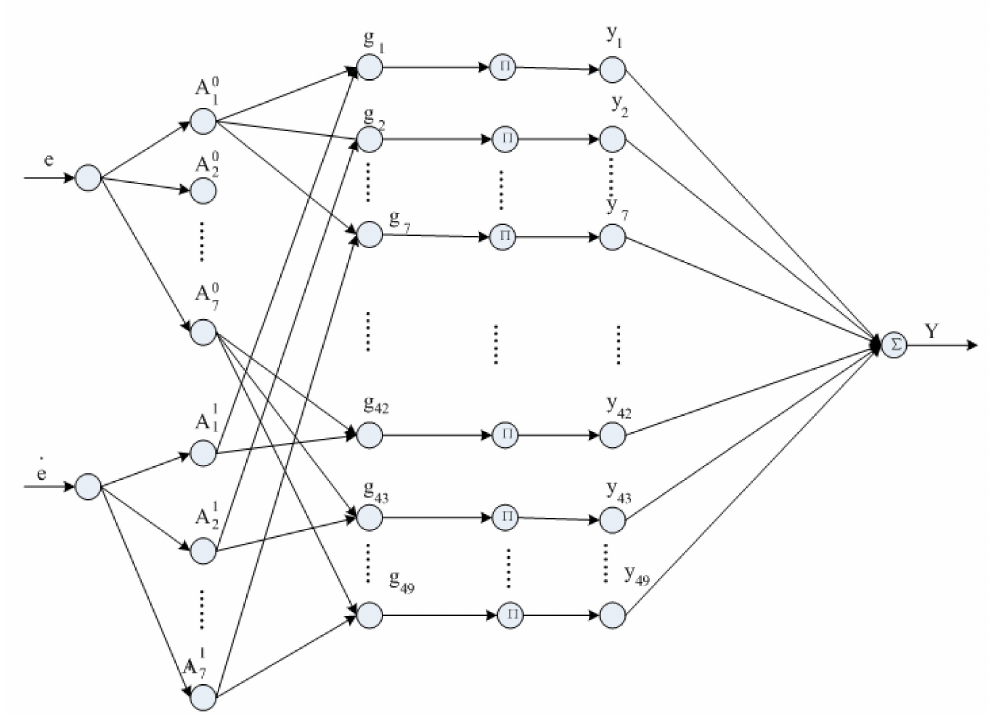
Figure 3. Structure of neuro-fuzzy controller for AUV path tracking